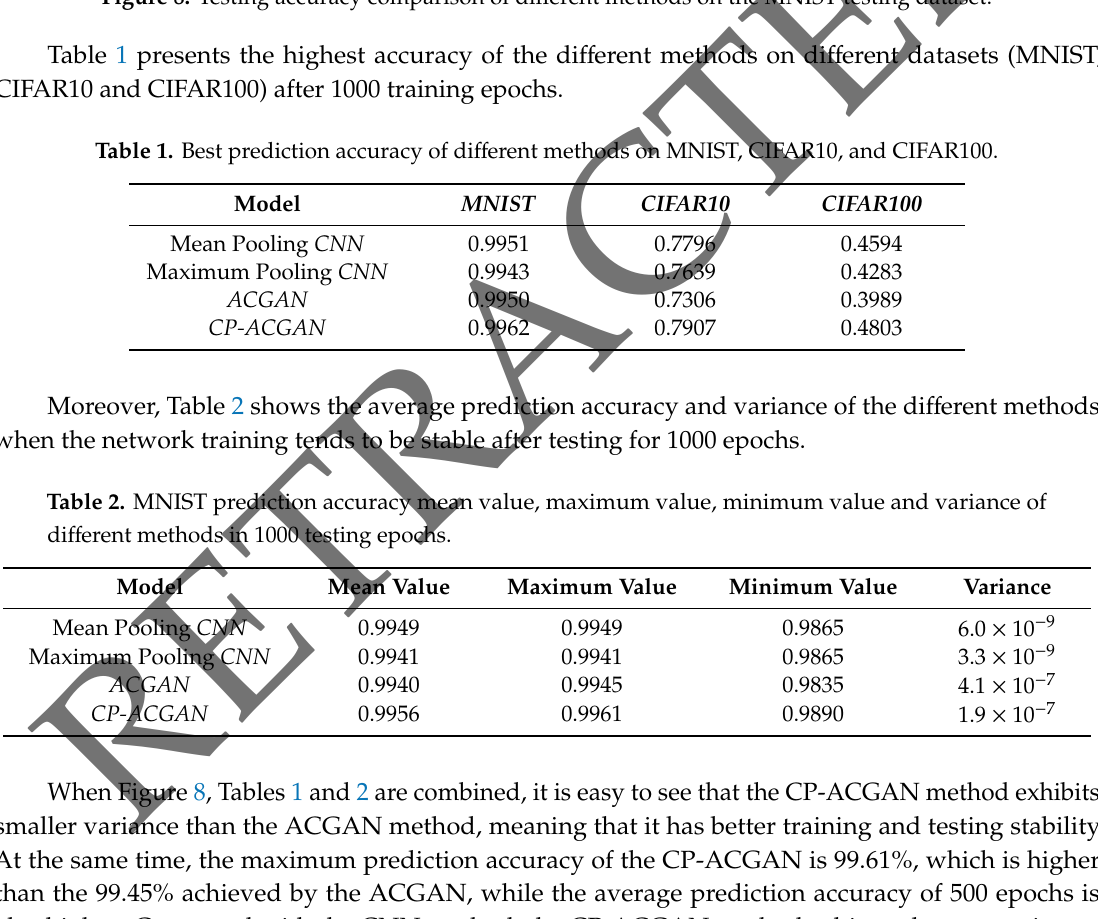
Figure 8. Testing accuracy comparison of different methods on the MNIST testing dataset.